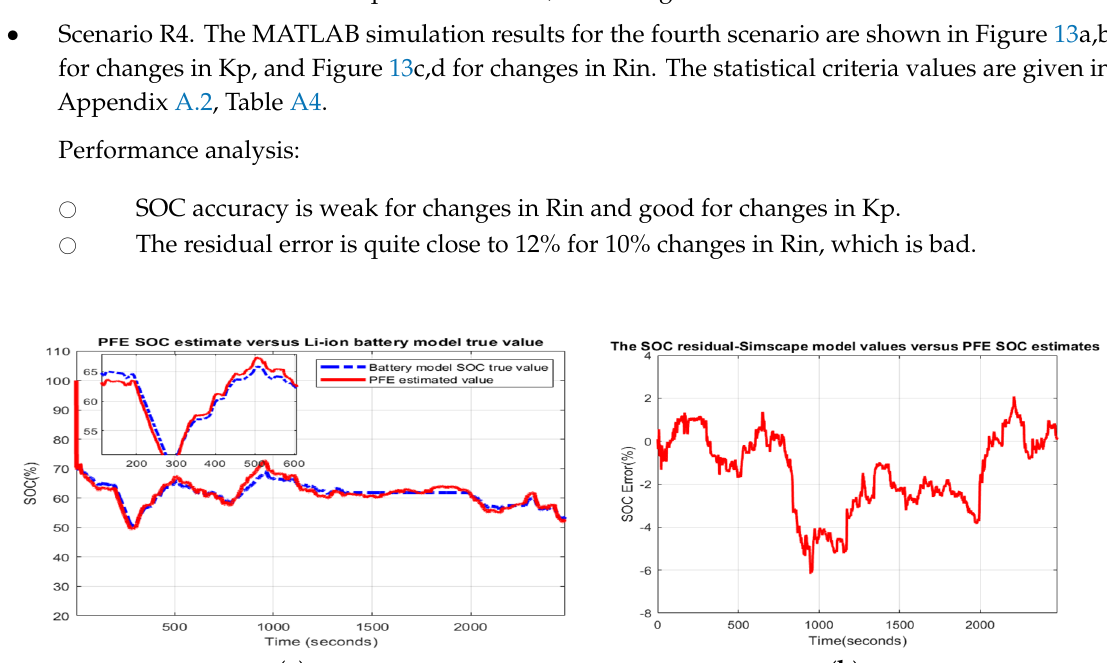
Figure 11. Robustness to simultaneous changes, SOCini = 0.2, and output temperature profile changes; ( a ) PFE SOC value versus 3RC ECM Li-ion battery model true value for changes only in Rin; ( b ) SOC residual for 20% changes in Rin.